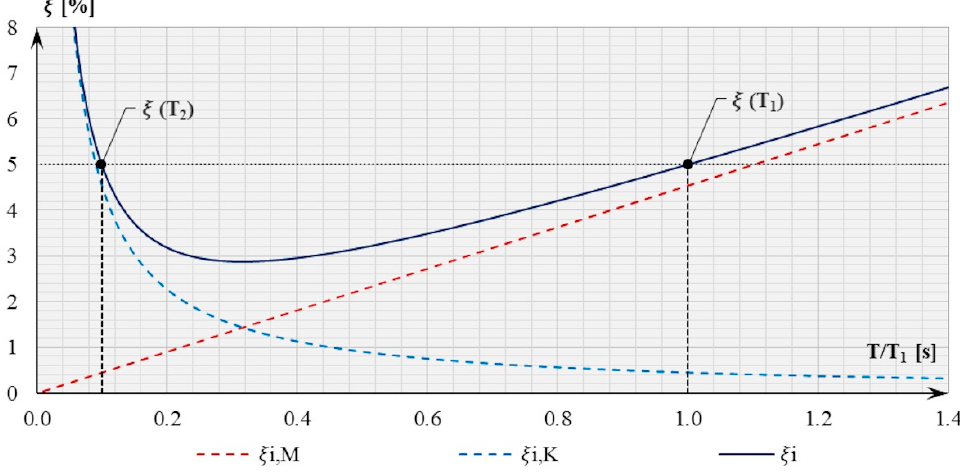
Figure 4. Rayleigh viscous (mass–tangent stiffness) proportional damping.